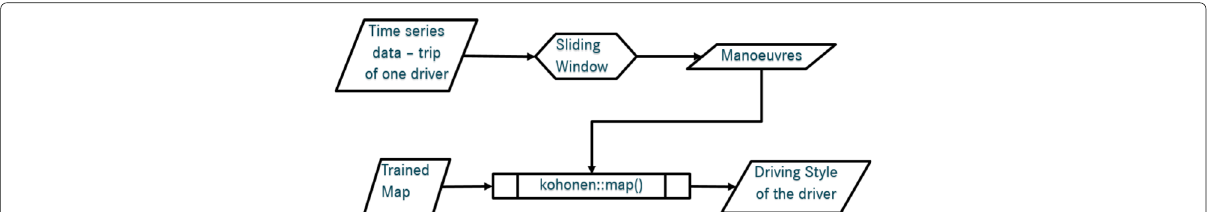
Fig. 2 Characterization Phase. Mapping trips of individual drivers onto a pre-trained